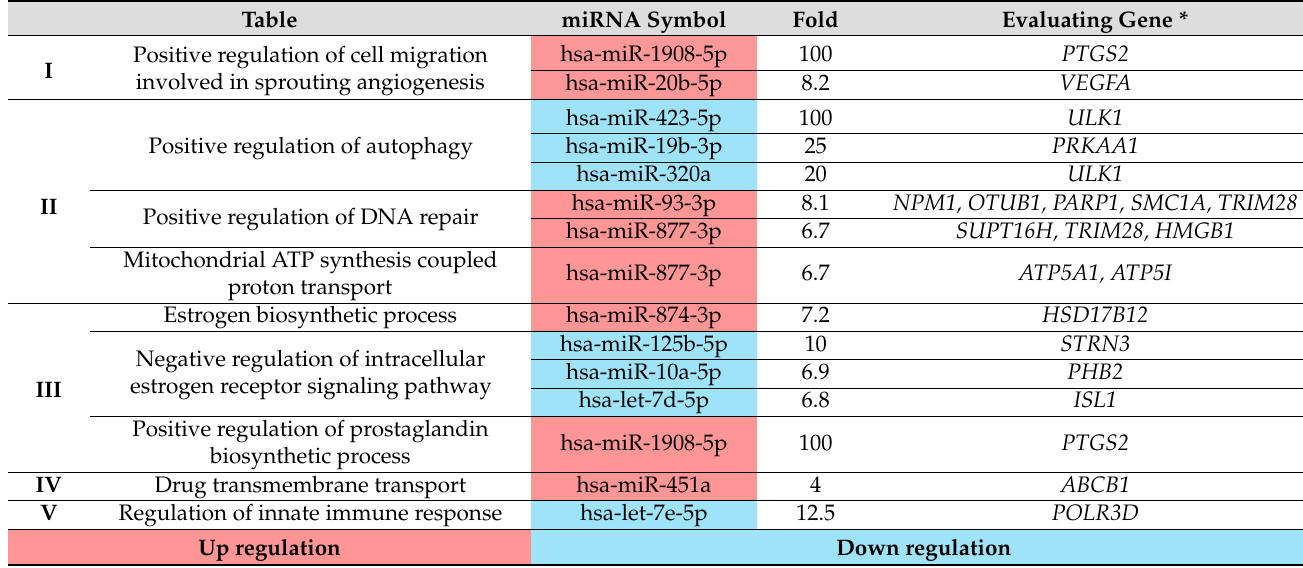
Table 1. Significant miRNAs involved in the five target biochemical categories and their modulating genes. Table miRNA